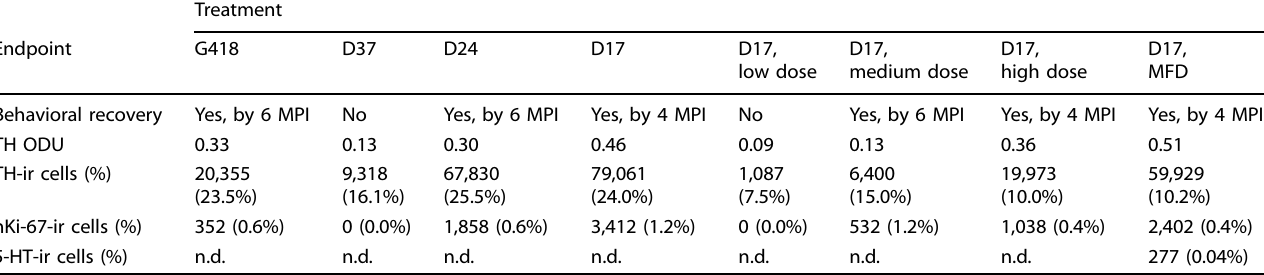
Table 1. Summary Table.